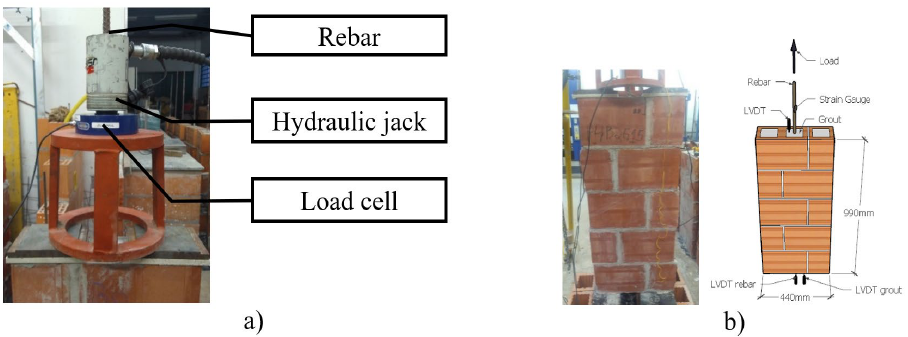
Figure 5. Scheme assay of pull-out